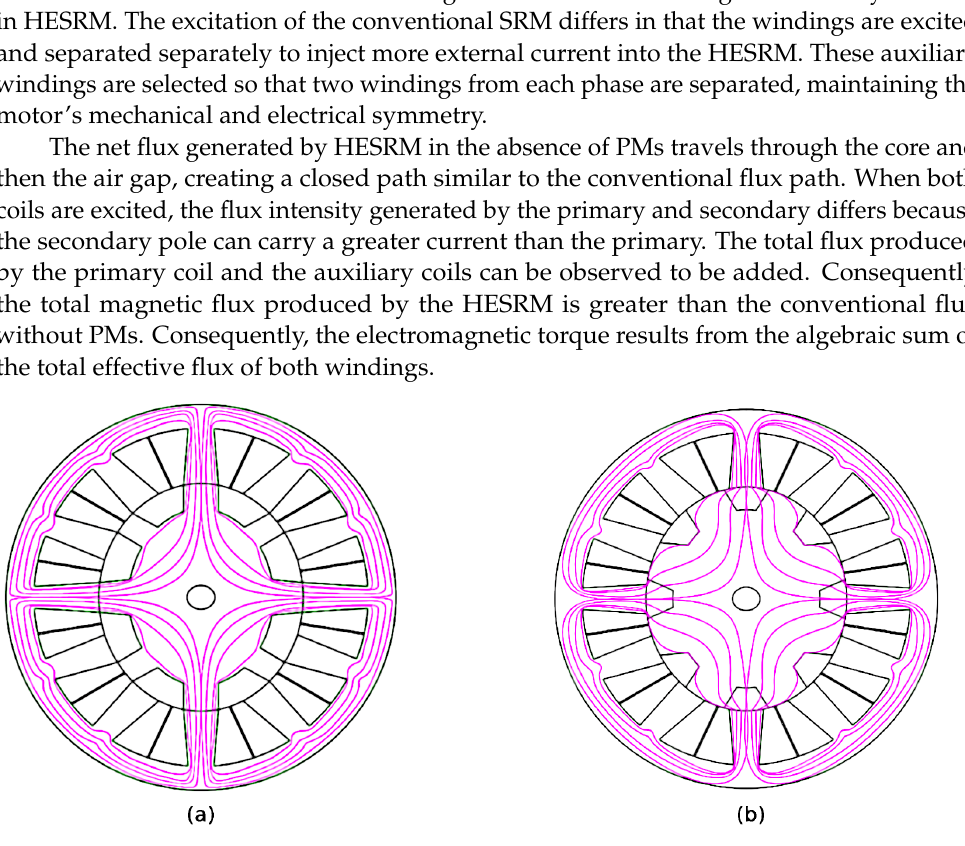
Figure 2. Magnetic field distributions of two SRMs with 12/8 poles s shown as: ( a ) aligned pole and ( b ) unaligned